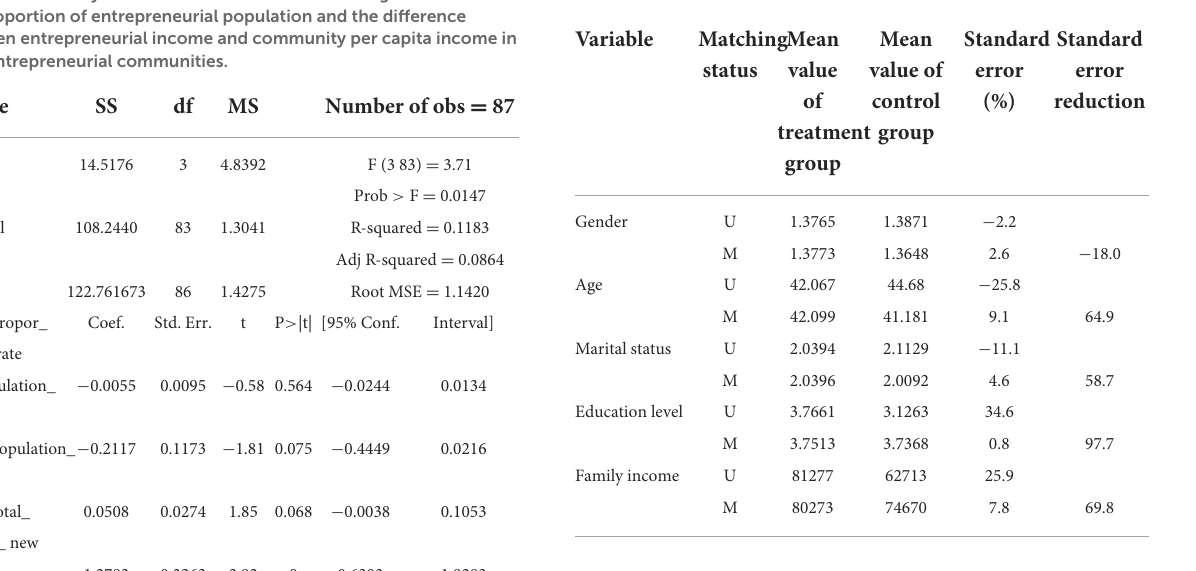
TABLE 9 Balance test of